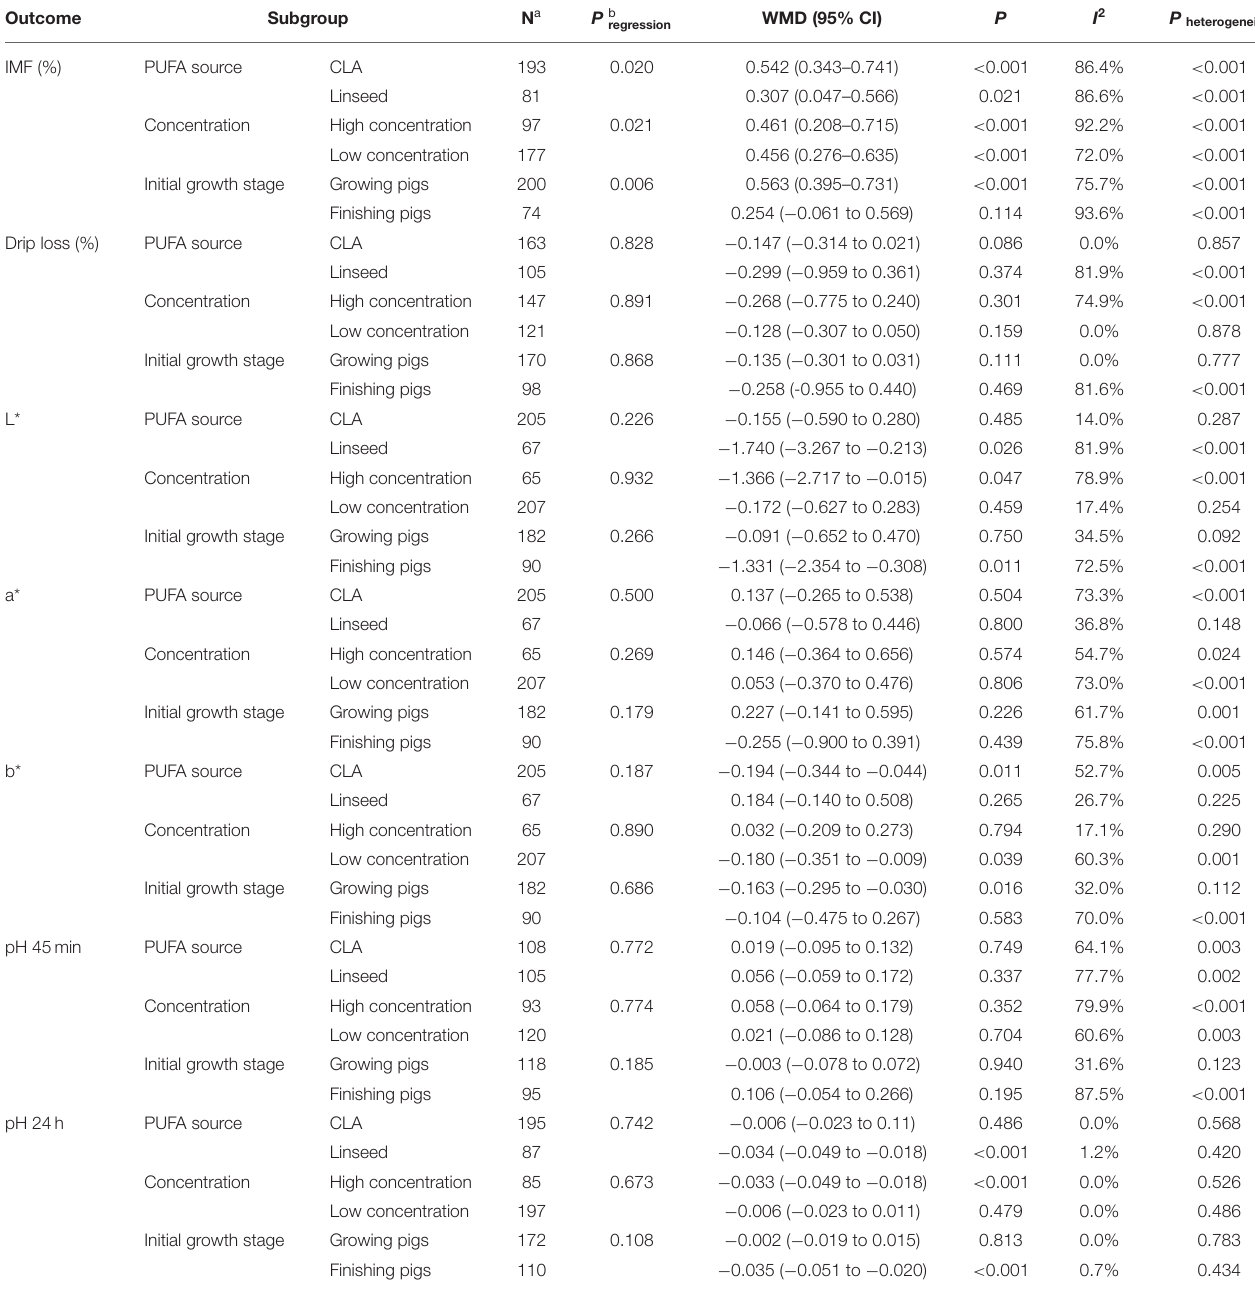
TABLE 4 | Regression and subgroup analysis of studies included in the meta-analysis.